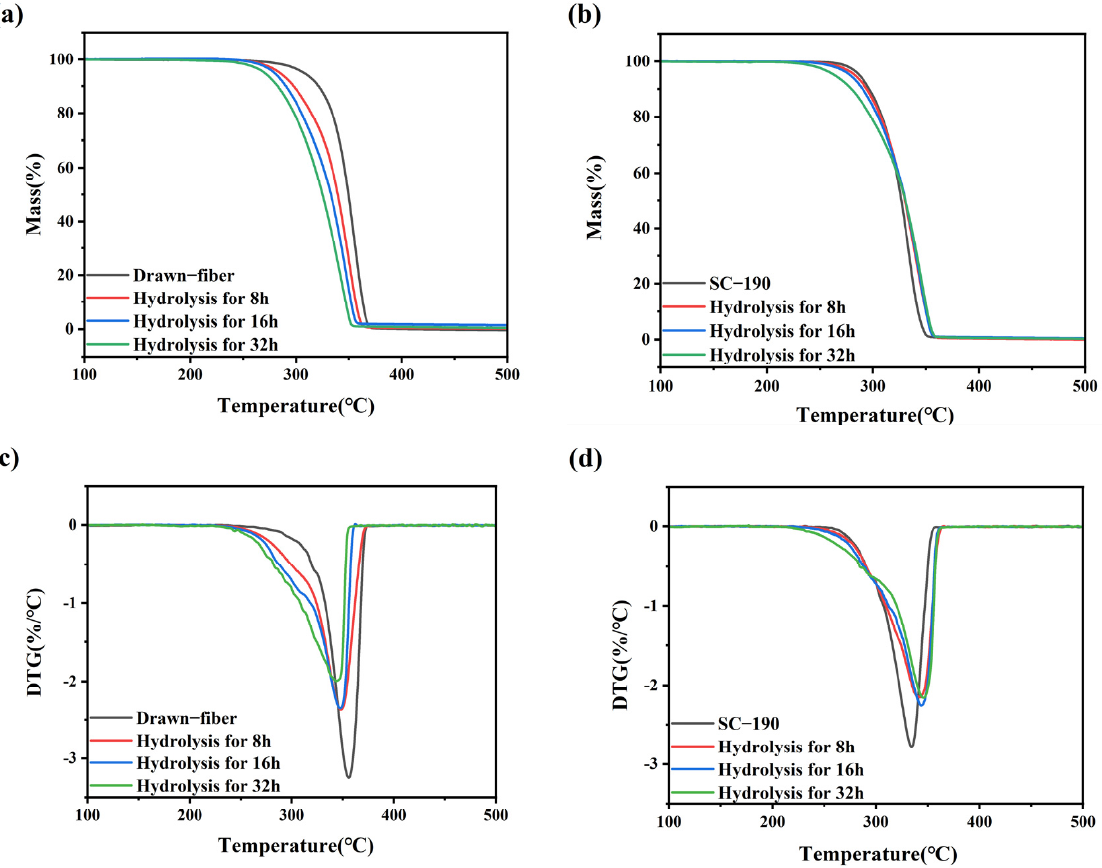
Figure 7. ( a ) TGA and ( c ) DTG curves of drawn − fiber and ( b ) TGA and ( d ) DTG curves of SC − 190 fiber hydrolyzed for different times.